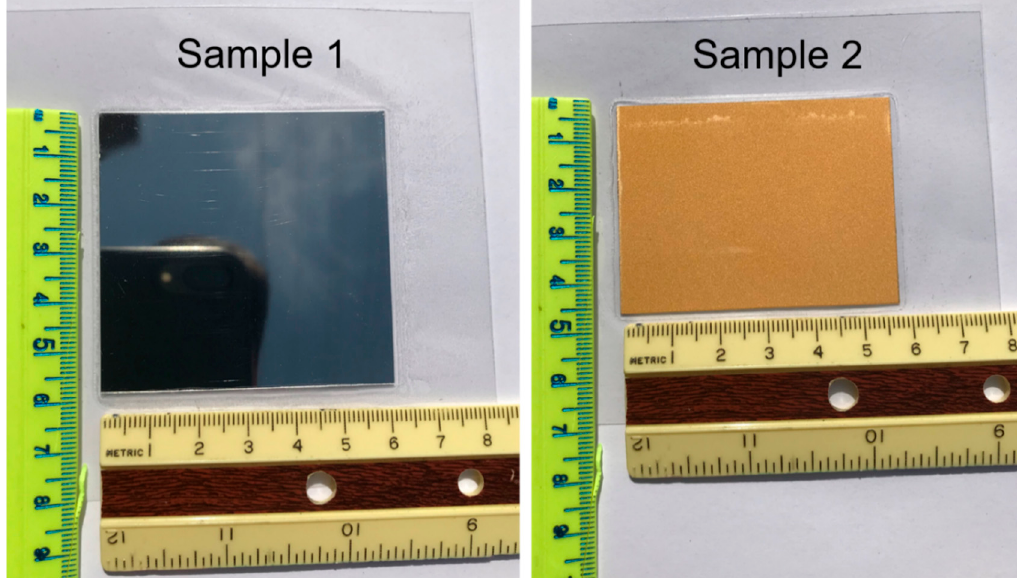
Figure 2. Artificial samples used within the Round Robin study of surface spectral emissivity described herein. Sample 1 was a 60 mm × 60 mm aluminium sheet laminated in a polyethylene covering to deliver a more specularly reflecting sample, whilst Sample 2 was a 47 mm × 57 mm gold sheet laminated in a polyethylene covering to deliver a more Lambertian reflecting sample. Both samples showed spectral regions of both high and low emissivity. A third SE reference sample consisting of distilled water was also used within laboratories capable of measuring liquid samples.